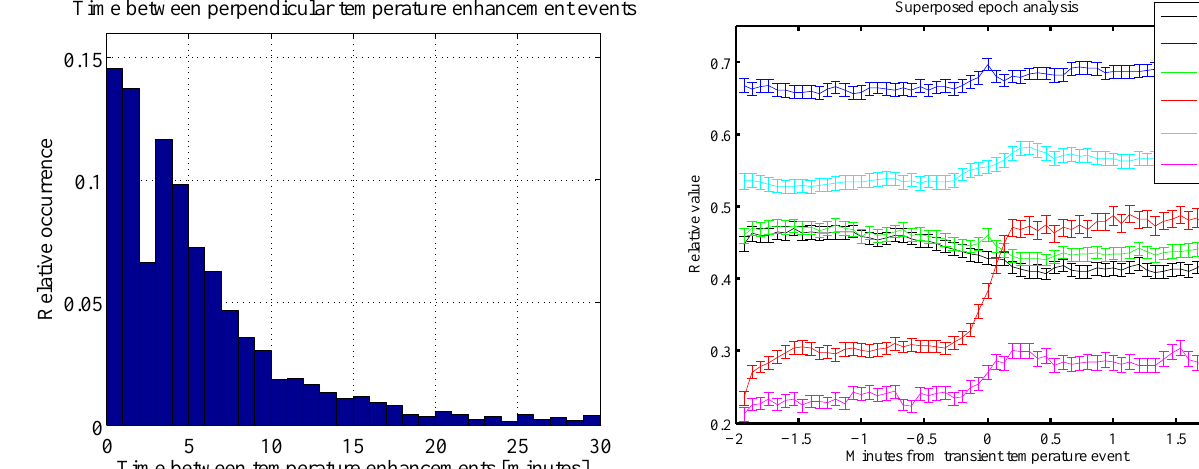
Fig. 5. Distribution of the time interval between perpendicular tem- perature enhancement events. The x-axis shows the time between temperature enhancement events [minutes]. The y-axis shows the occurrence frequency.